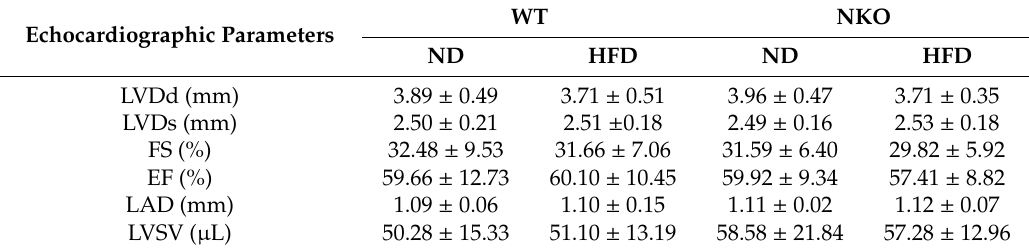
Table 1. Echocardiographic Findings.